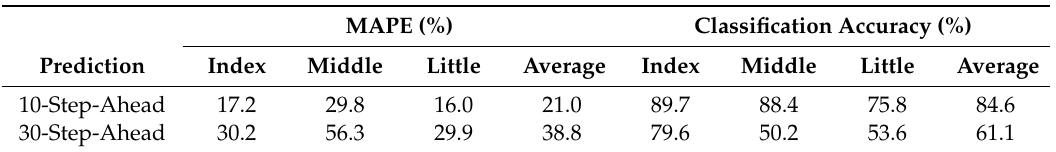
Table 1. Mean absolute percentage error (MAPE) versus classification accuracy based on 4-layer TDNN model, for each time step. MAPE (%) Classification Accuracy